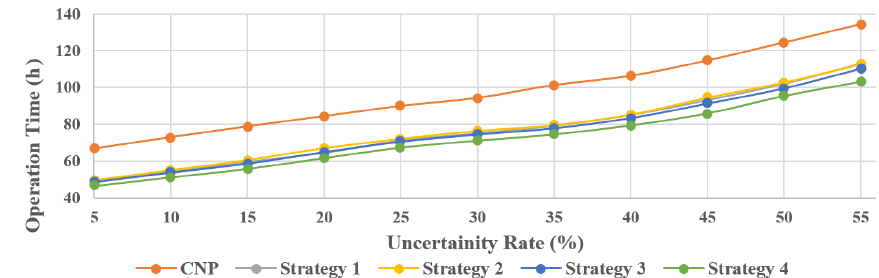
Figure 10. Uncertainty analysis when different values were used in determining